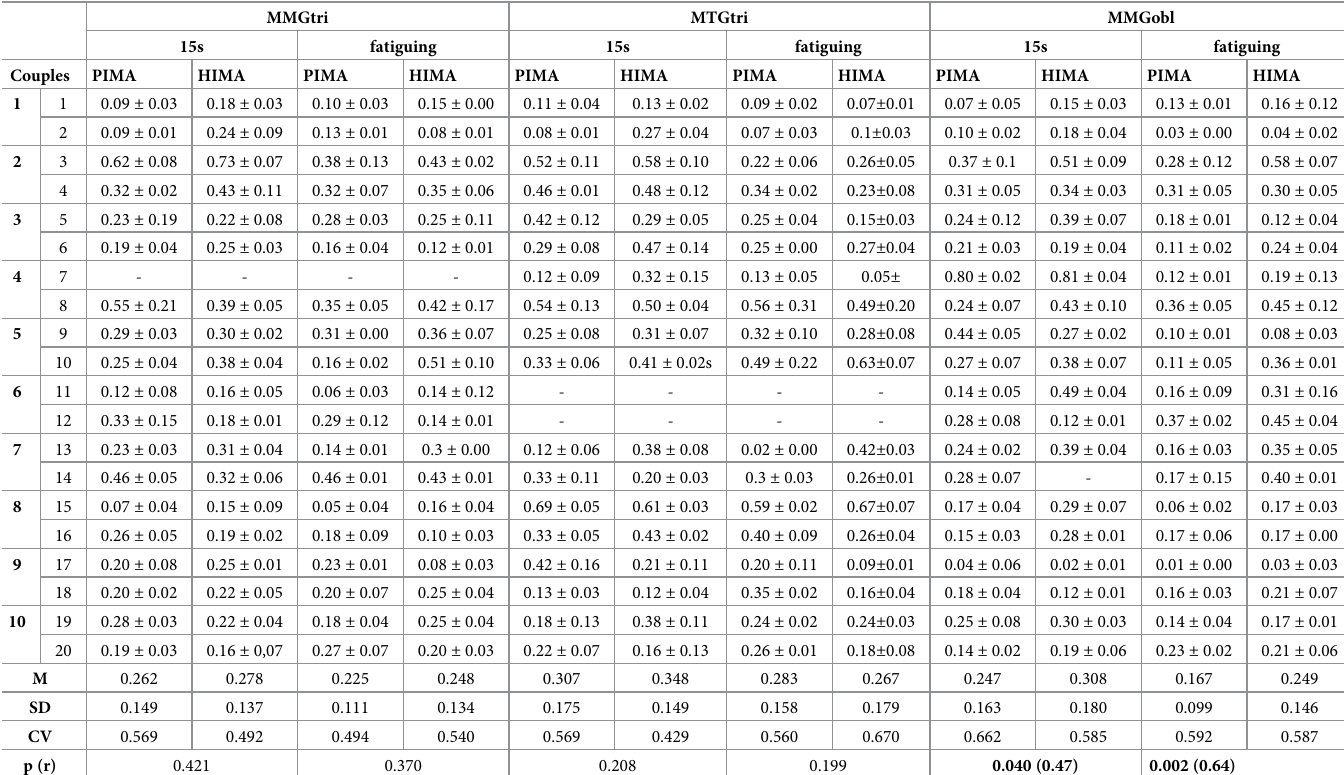
Table 4. Power-frequency ratio MQ REL